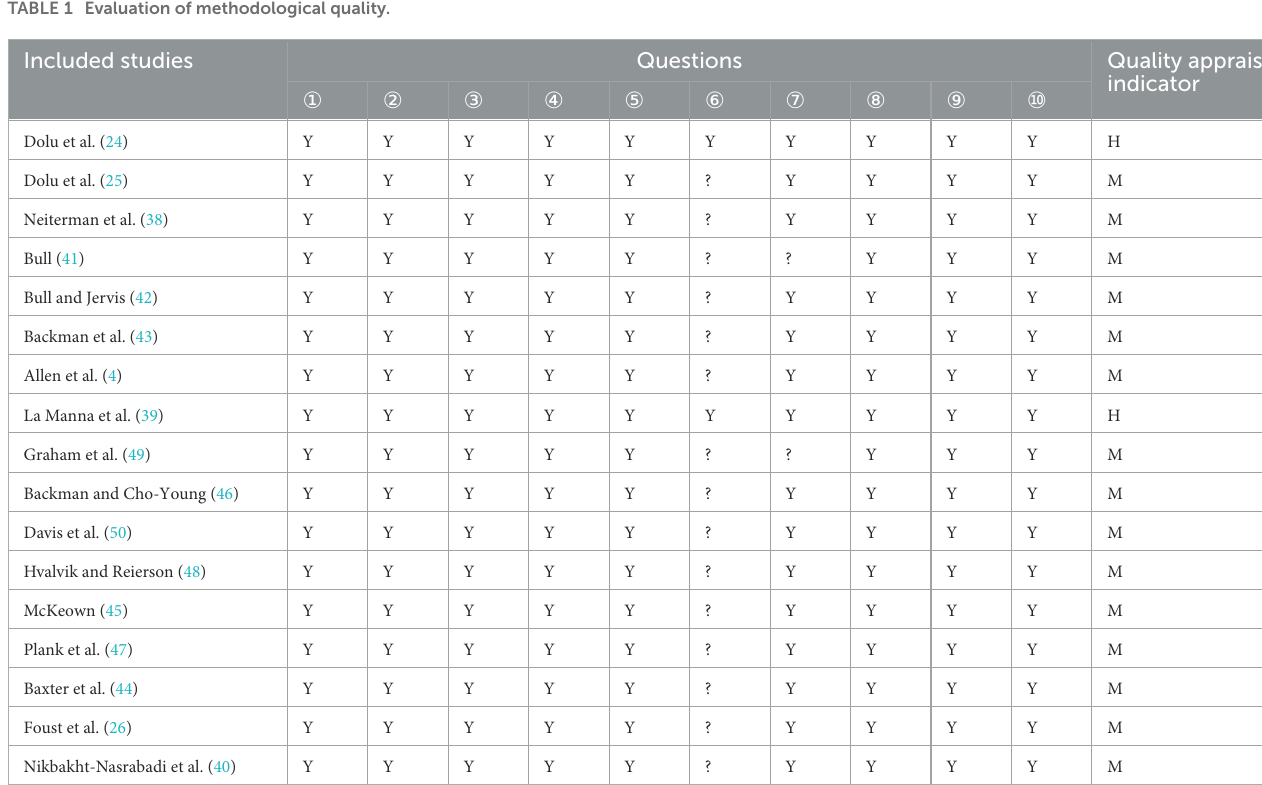
TABLE 1 Evaluation of methodological